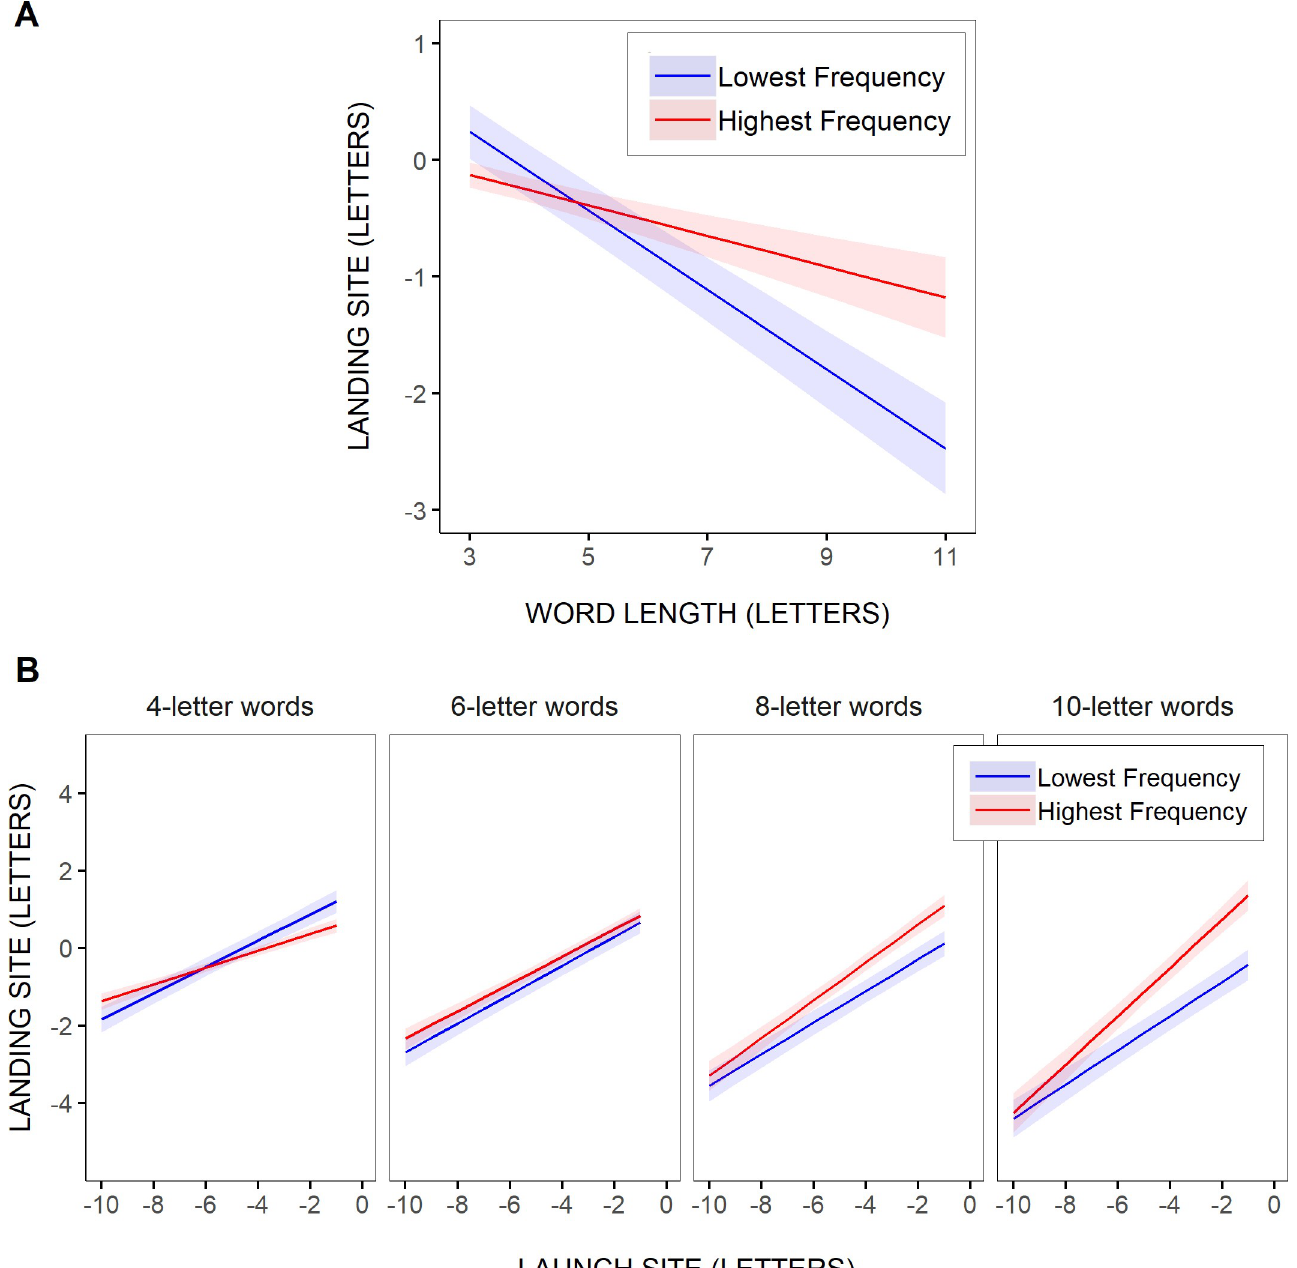
Fig 10. Estimated within-word landing positions. Partial effects (with 95% confidence intervals) computed from LMM parameters (Table 7), representing within-word initial landing positions for all words in the sentences as a function of word length (in letters; A), and for 4-, 6-, 8-, and 10-letter words as a function of launch-site distance (in letters relative to the space in front of the words; B), separately for the two most extreme word-frequency values across all selected words regardless of their length (-2.66 and 9.59 log units respectively;